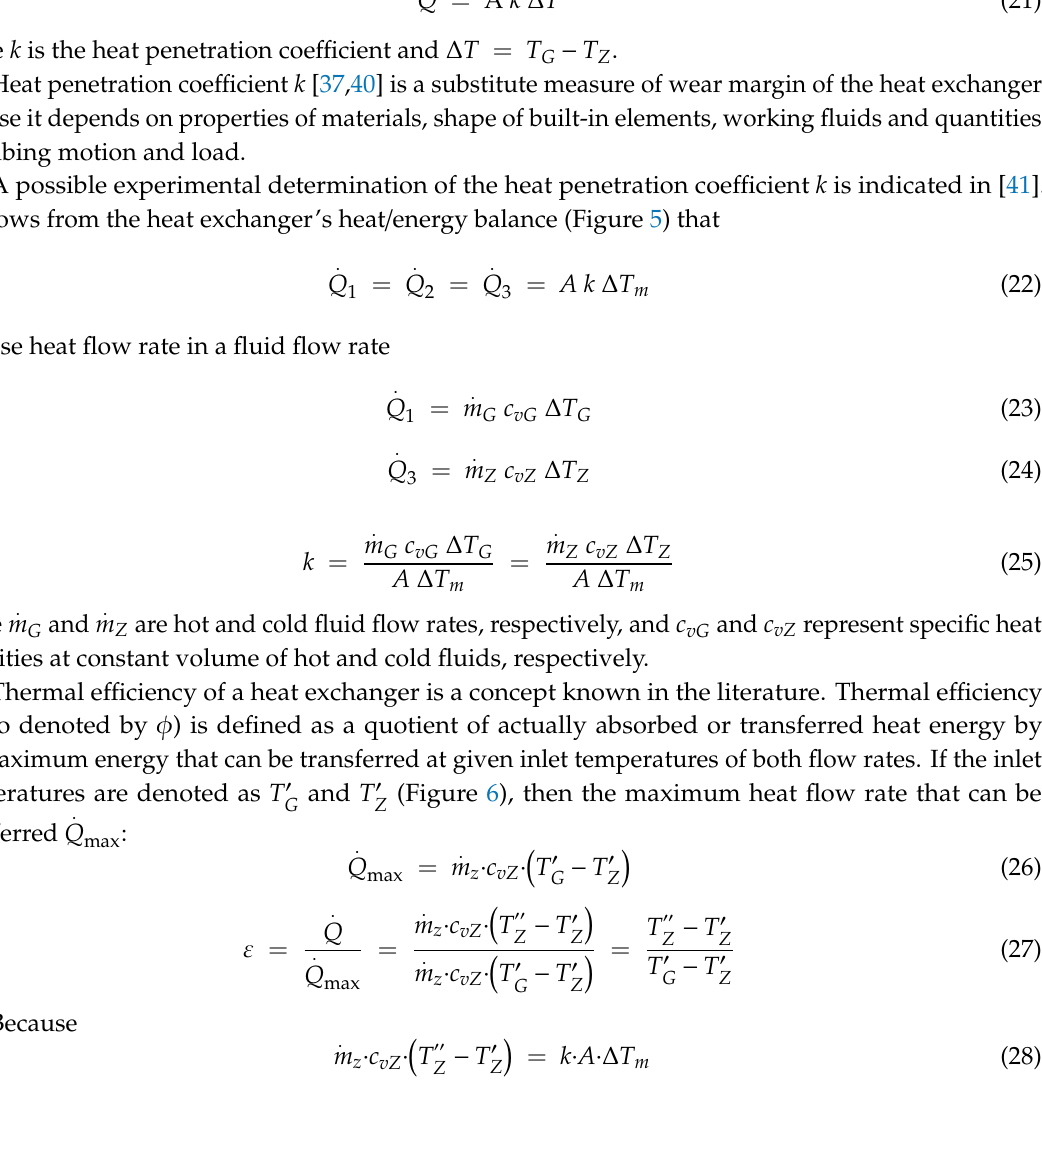
and T (cid:48) are initial temperatures Z G and T (cid:48)(cid:48) are the final temperatures of the fluids Z G